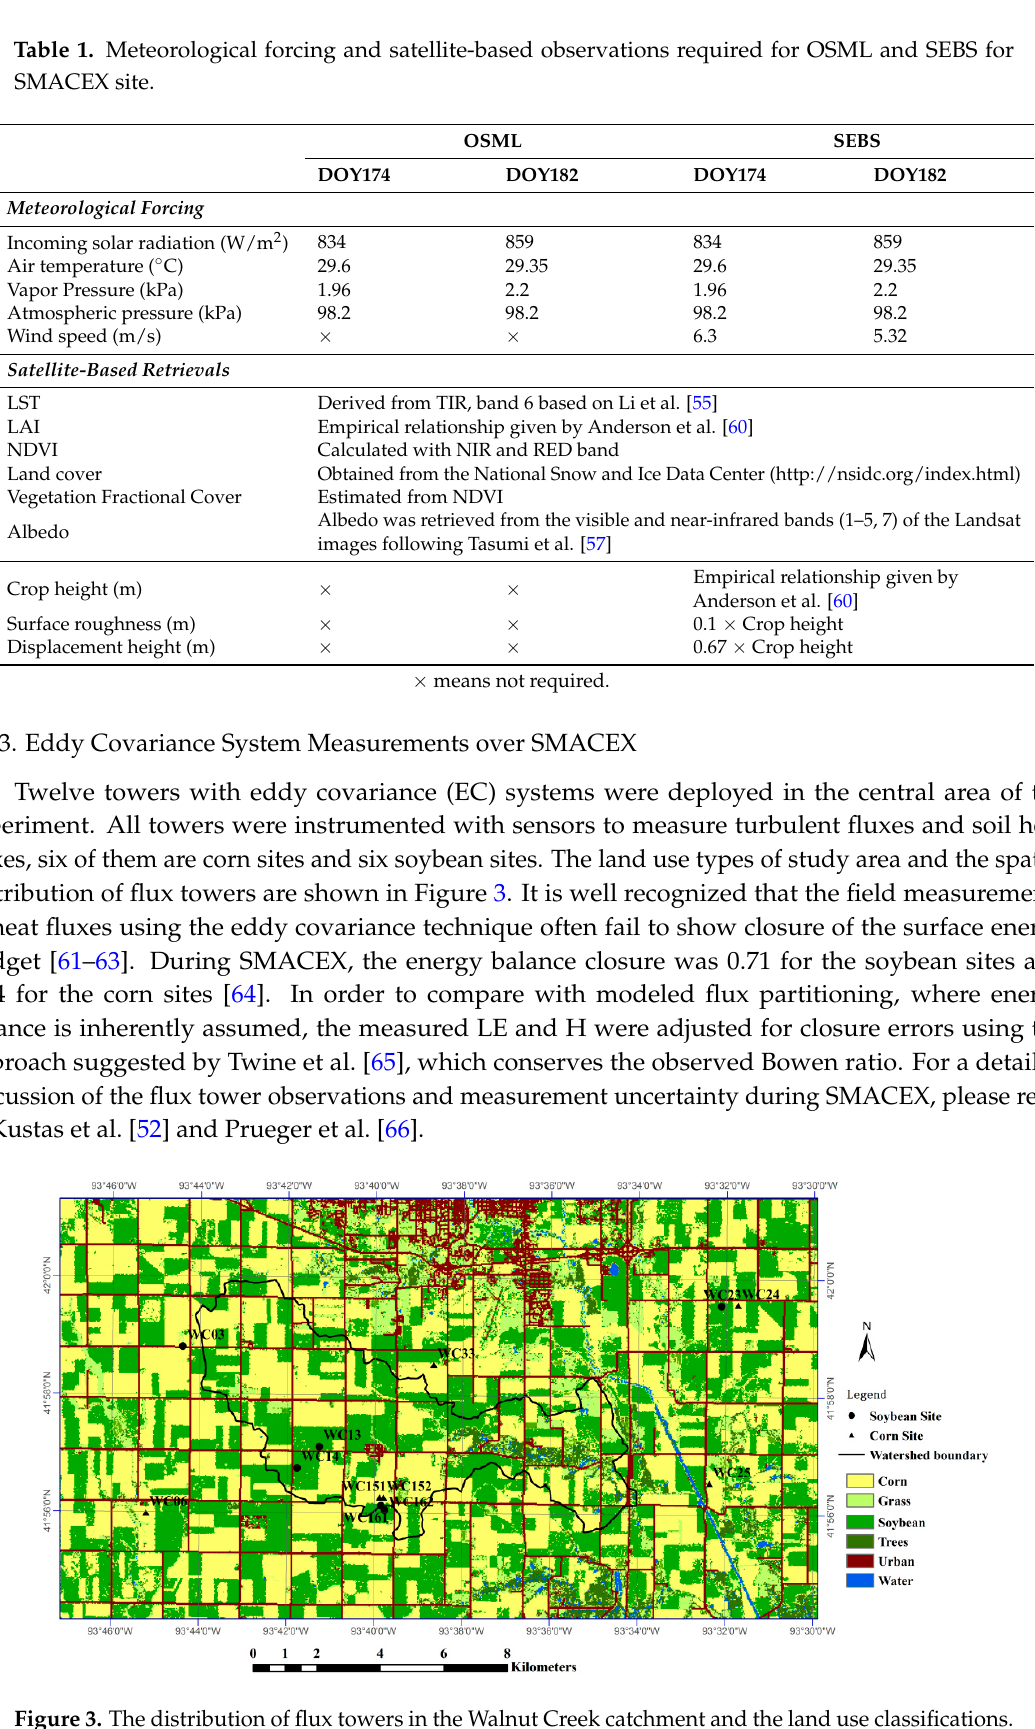
Figure 3. The distribution of flux towers in the Walnut Creek catchment and the land use classifications.